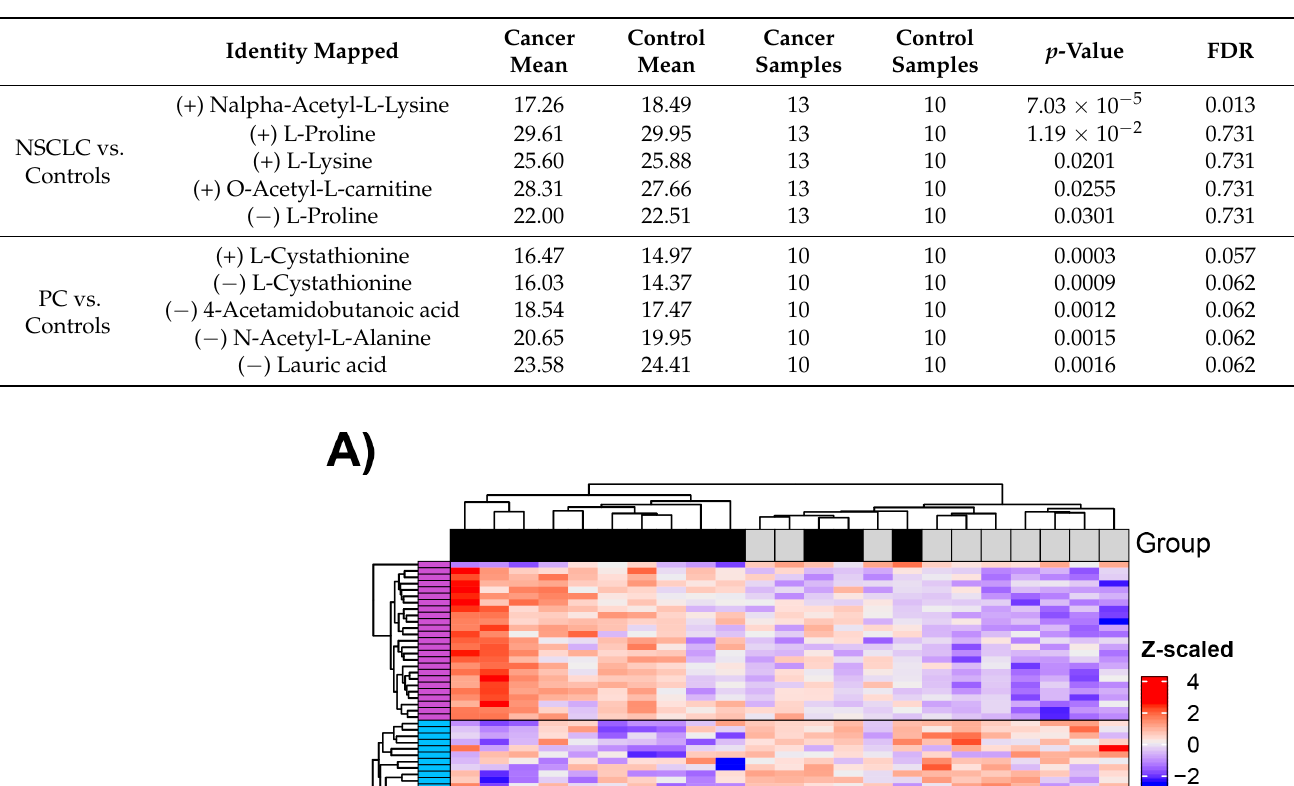
Table 3. Top 5 differentially abundant metabolites from SEC enriched exosomes in NSCLC and CRPC.